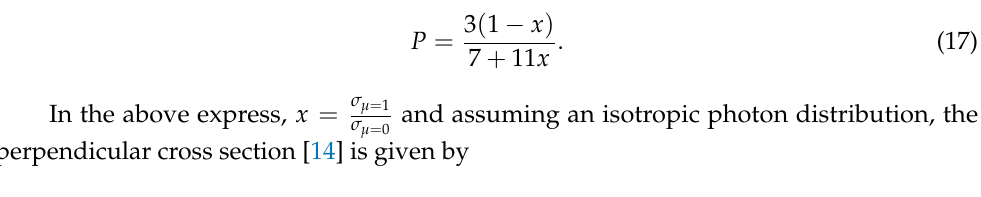
Figure 2. (Color online). Threshold behavior of 2 P excitation cross sections ( a 2 energy E